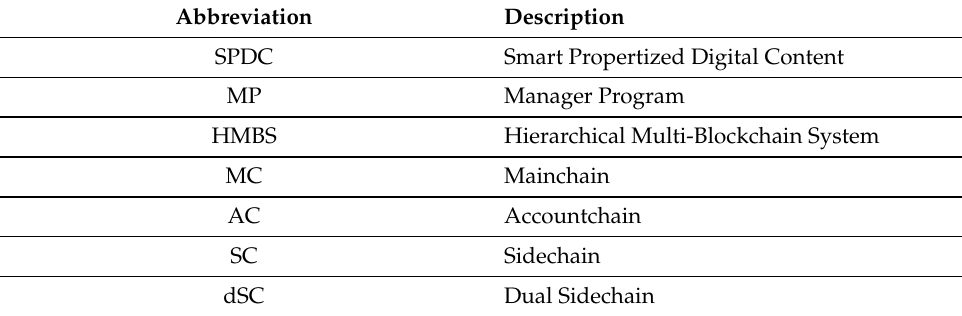
Table 1. A list of abbreviations.